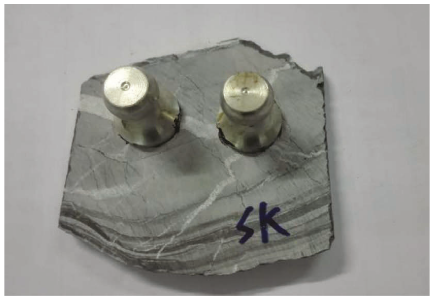
Figure 4: Specimen for bond strength